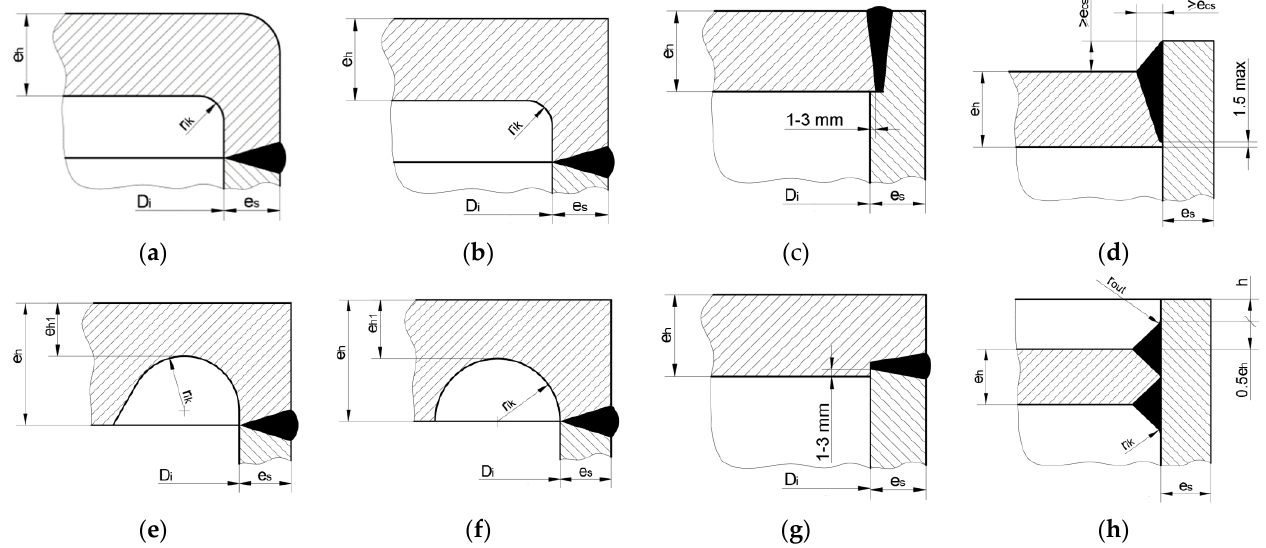
Figure 1. Standardized design of flat ends of pressure vessels ( a ) type “a” with fillet radius r ik ; ( b ) type “b” with fillet radius r ik ; ( c ) type “c”; ( d ) type “d”; ( e ) type “e” with SRG and with inclination; ( f ) type “f” with SRG; ( g ) type “g”; ( h ) type “h” with double-sided T-weld.